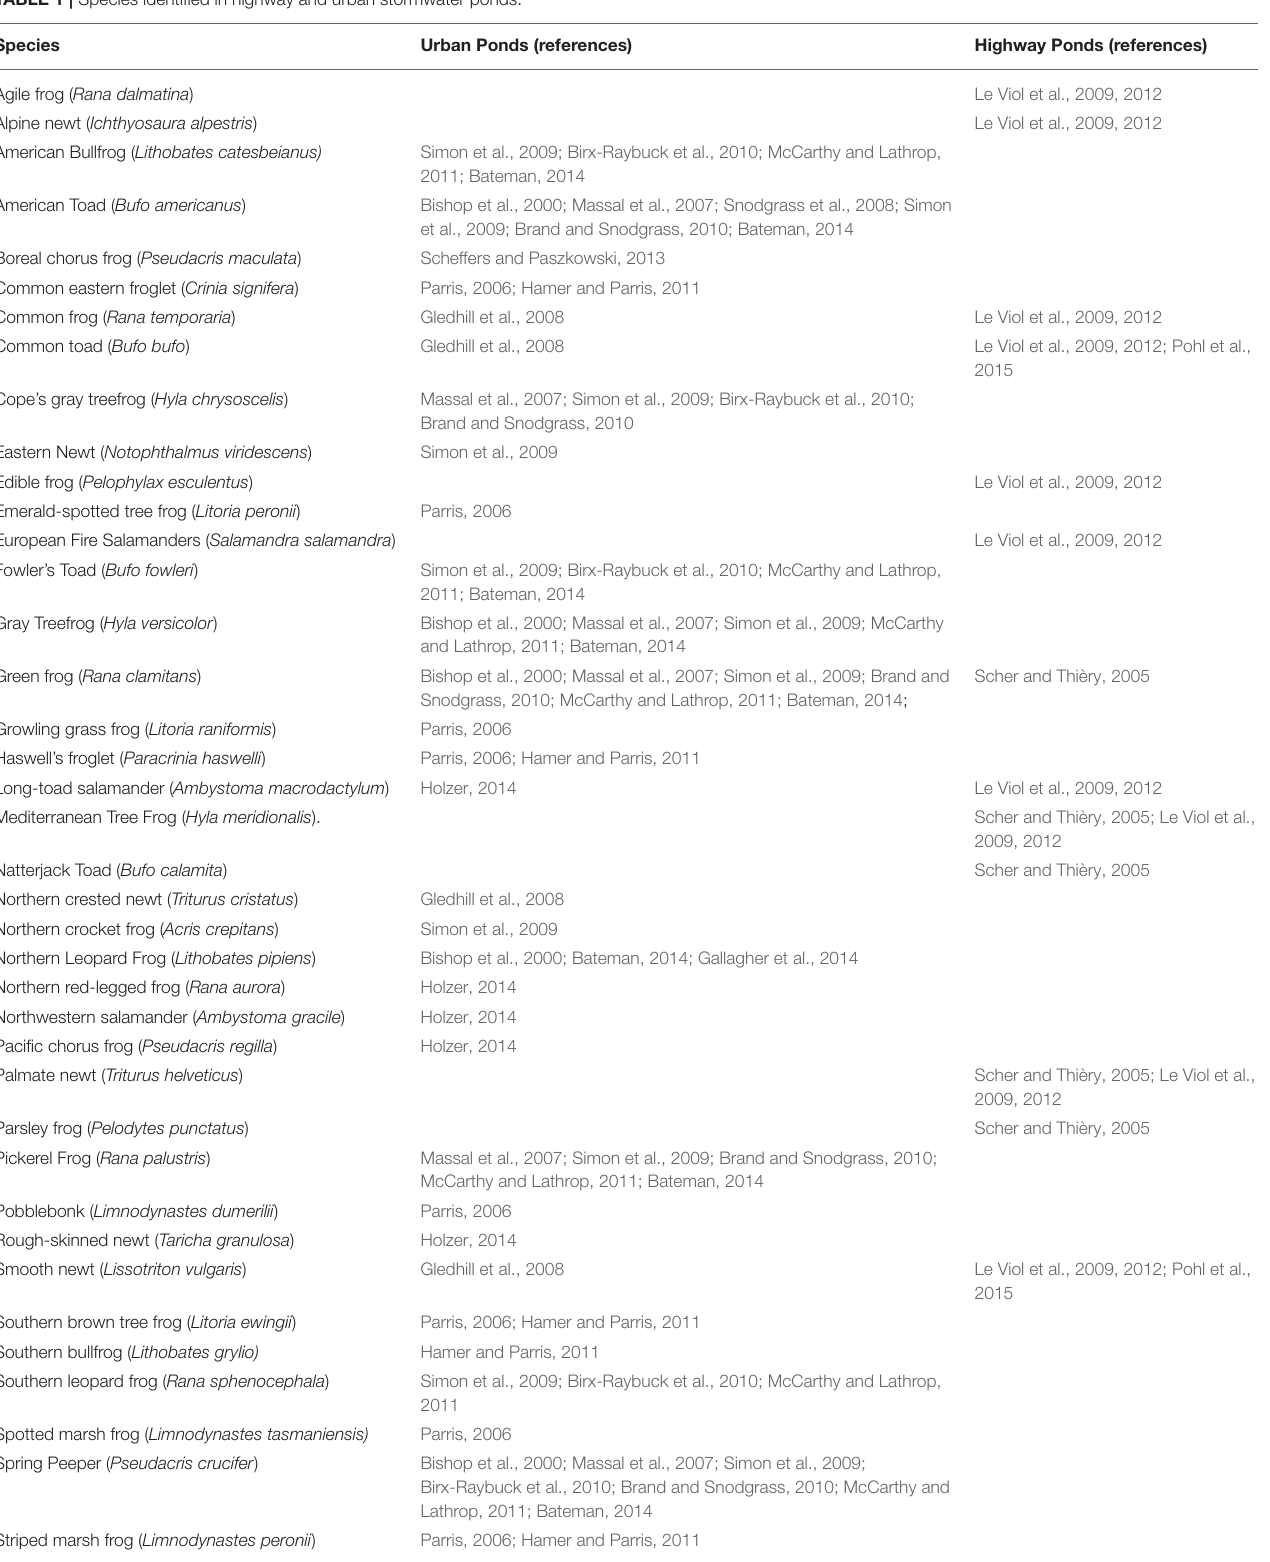
TABLE 1 | Species identified in highway and urban stormwater